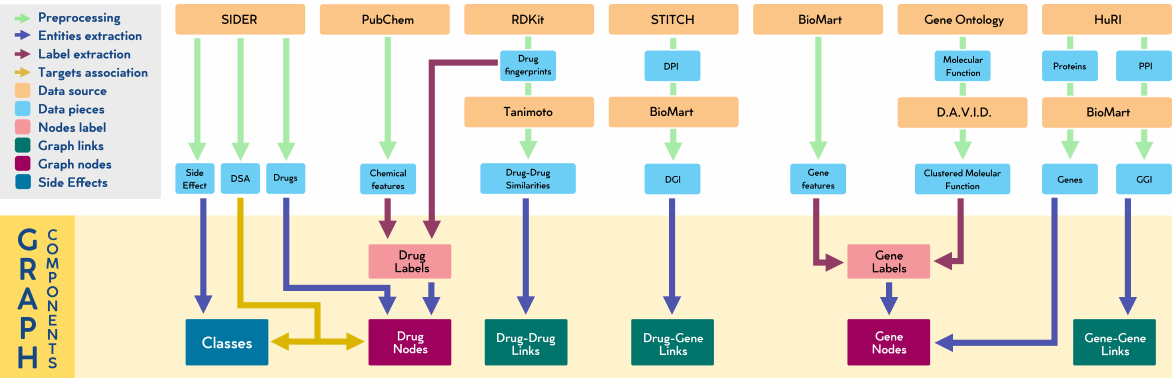
Figure 3. Sketch of the DruGNN original dataset’s construction. The information flows from the orange and cyan rectangles representing data sources and data pieces to the final graph representation, in which purple and pink rectangles represent graph nodes and their features, green rectangles stand for the edges between nodes and blue rectangles represent the labels of a subset of the drug